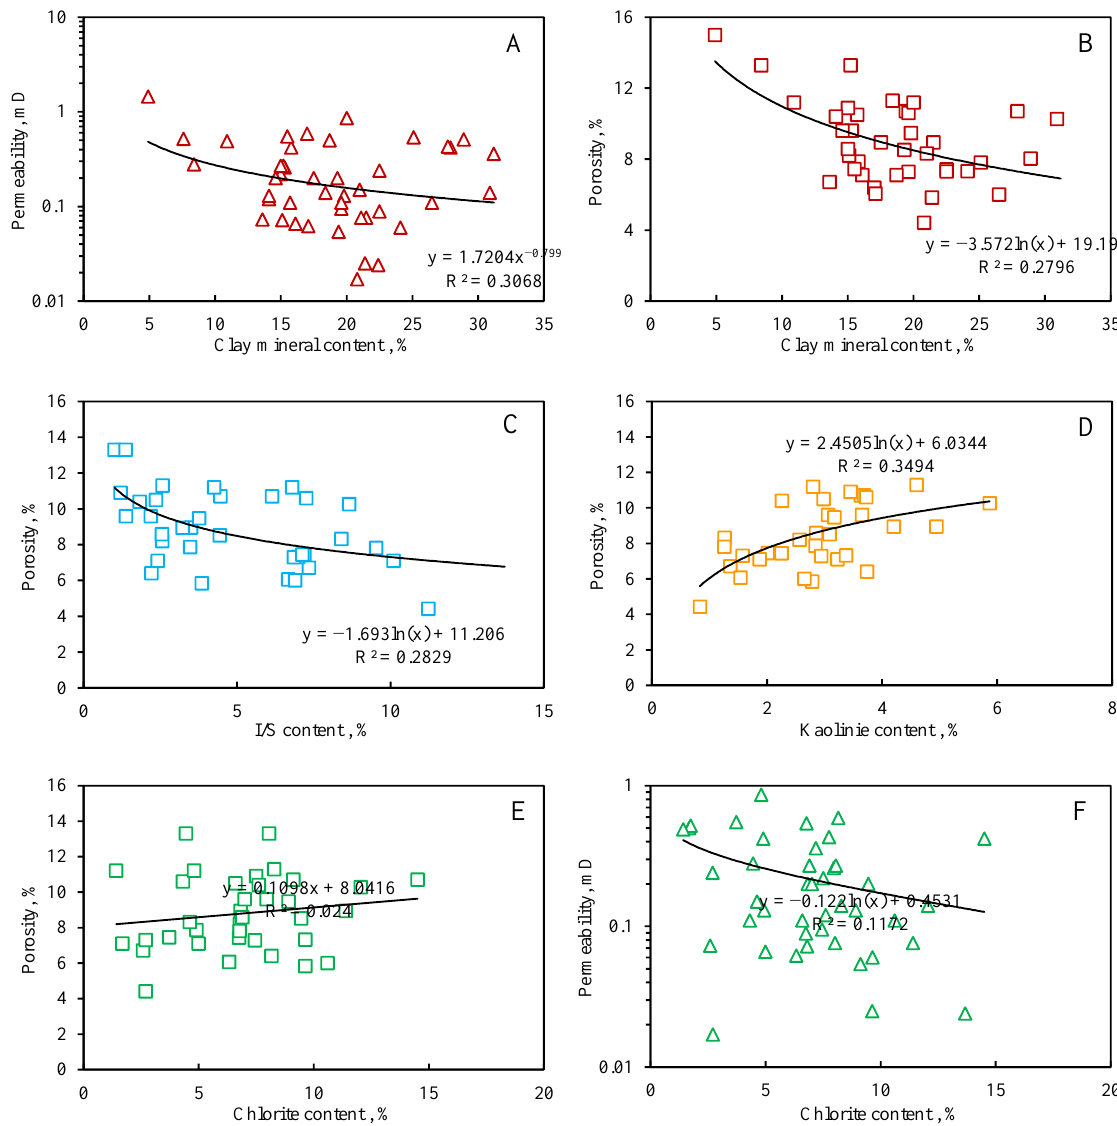
Figure 10. Correlations between the porosity and permeability and the contents of the clay minerals for the samples from the Mahu area ( A – F ).